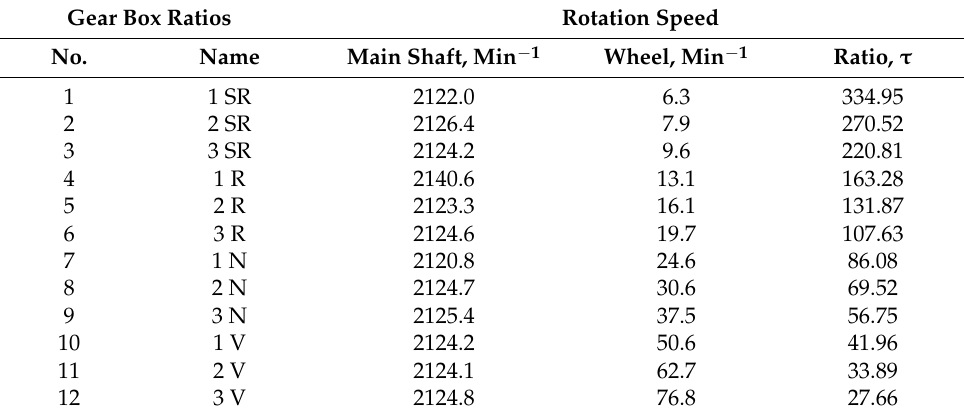
Table 3. Transmission ratios between gear box and